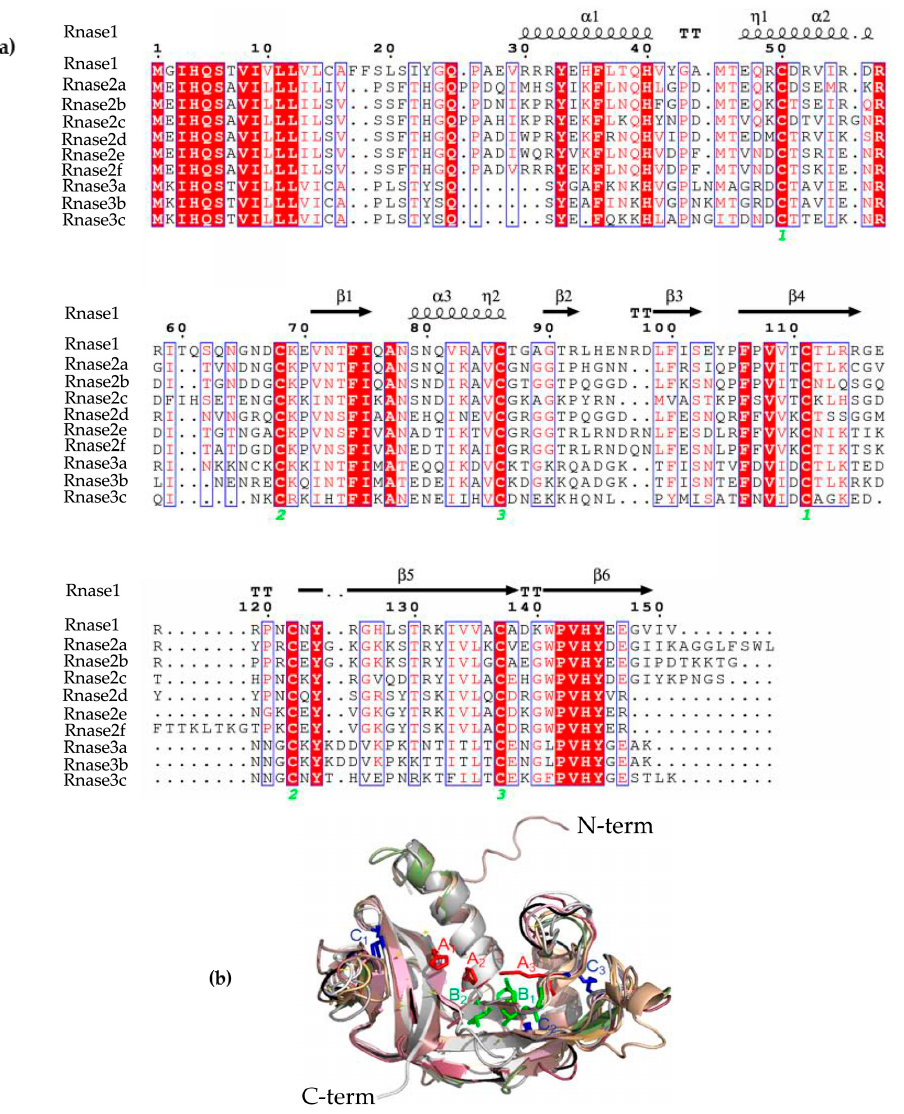
Figure 2. ( a ) Sequences alignment of M. amblycephala Rnase1 , Rnase2a , Rnase2b , Rnase2c , Rnase2d , Rnase2e , Rnase2f , Rnase3a , Rnase3b and Rnase3c . Secondary structure elements of Rnases are depicted at the top. Cysteine pairings (disulfide bridges) are numbered in green below the columns. Locations of three α -helices ( α 1- α 3) and six β -strands ( β 1- β 6) are shown above the sequences. The figure was created using ESPript software. ( b ) Representation of the superimposed three-dimensional structures of all ten Rnases of M. amblycephala . The image was drawn using PYMOL. Catalytic residue regions are shown in red (A1-A3), conserved binding sites in green (B1, B2), and disulfide bond binding sites in blue (C1-C3).